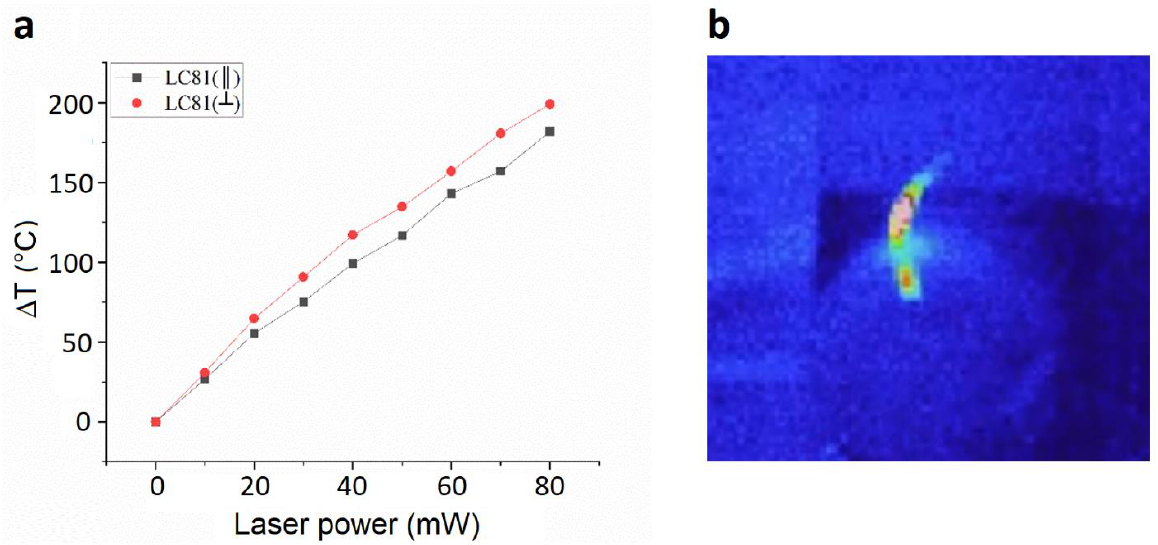
Figure 9. Thermographic analysis: ( a ) maximum temperature increases (ΔT) that the film reaches when irradiated with a laser wavelength of 457 nm with power in the range 0–80 mW, ( b ) example of thermal image acquired during the measurements.